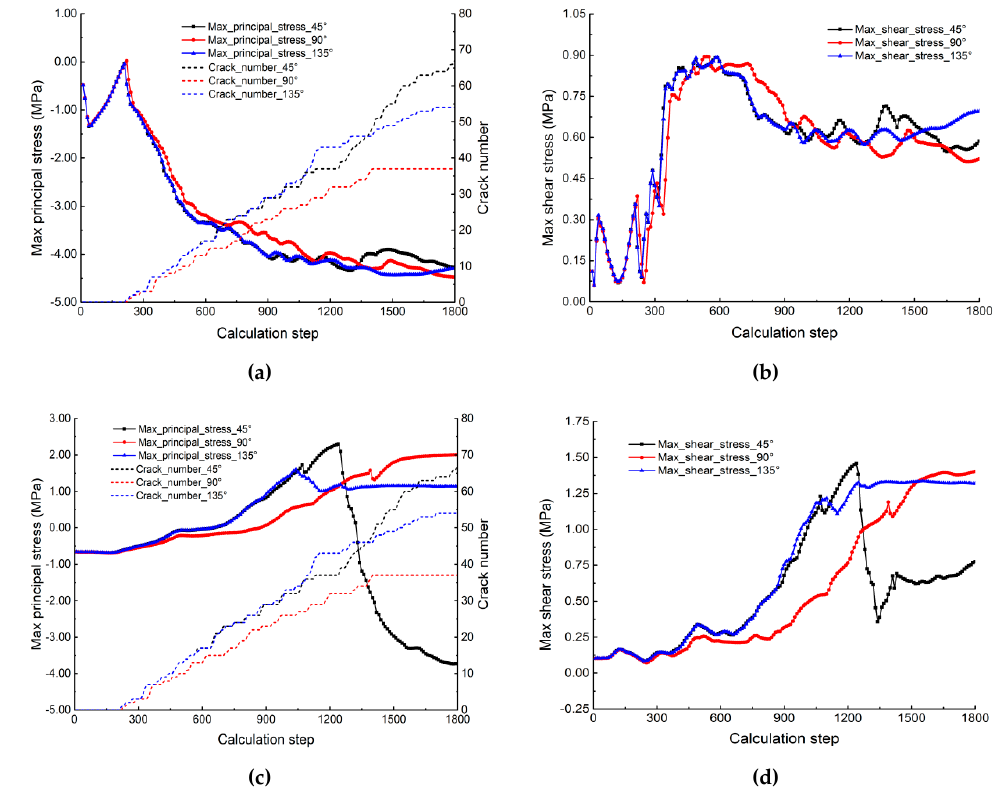
Figure 11. Principal stress curves of Group 2B under water pressure of 7.35 MPa: ( a ) max principal stress history curve of Mc1; ( b ) max shear stress history curve of Mc1; ( c ) max principal stress history curve of Mc2; and ( d ) max shear stress history curve of Mc2.